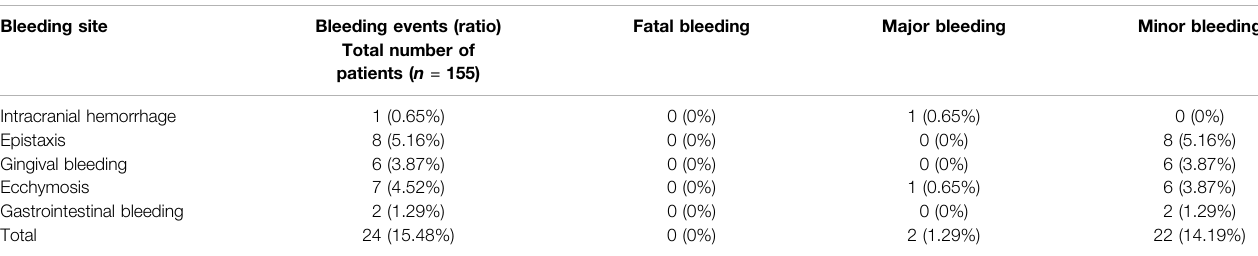
TABLE 7 | Description of bleeding events. Bleeding site Bleeding events (ratio)